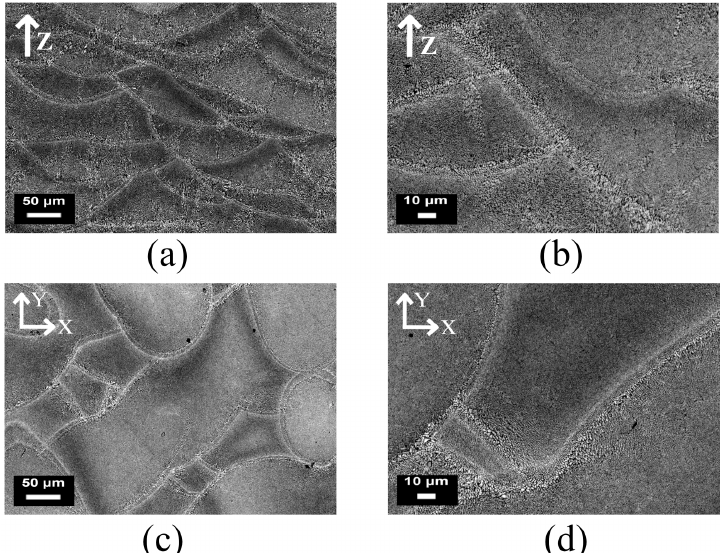
Figure 9. Optical micrographs of AlSi10Mg samples obtained by means of DMLS, built using a rotated scanning strategy (67° of rotation between subsequent layers), at different magnifications: ( a , b ) describe a vertical section of the part along the building direction ( z axis), while ( c , d ) show the section parallel to the building plane ( xy -plane).